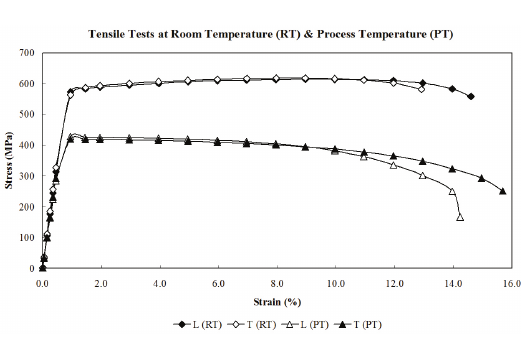
Figure 9. Creep machine and laser extensometer used for tests [Spirit Aerosystems].